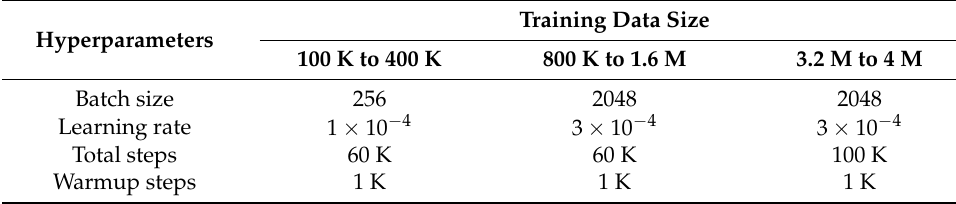
Table A1. Hyperparameters used for post-training.